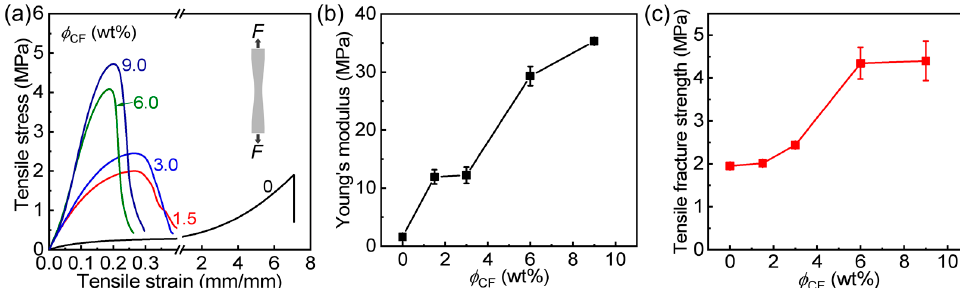
Figure 3. This is a figure. Schemes follow the same formatting. Tensile behavior of PA/CF composite hydrogels with different contents of cellulose-based fiber ( ϕ CF ). ( a ) Stress-strain curves of the samples. ( b ) Young’s modulus versus ϕ CF . ( c ) Tensile fracture strength versus ϕ CF .